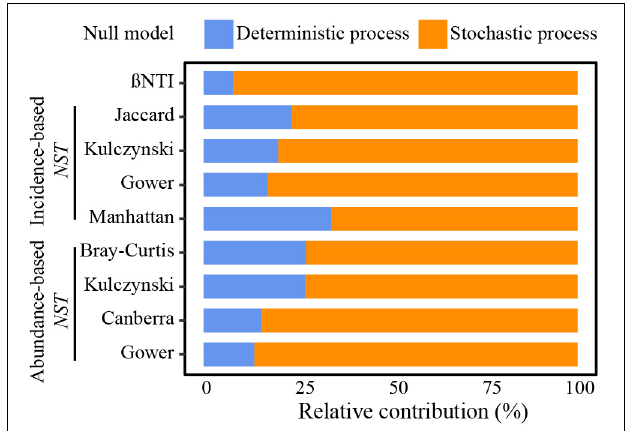
FIGURE 3 | The relative effect of deterministic and stochastic processes governing the UCYN-A community assembly. The contribution was evaluated by various null models with different algorithms and community similarity indices.